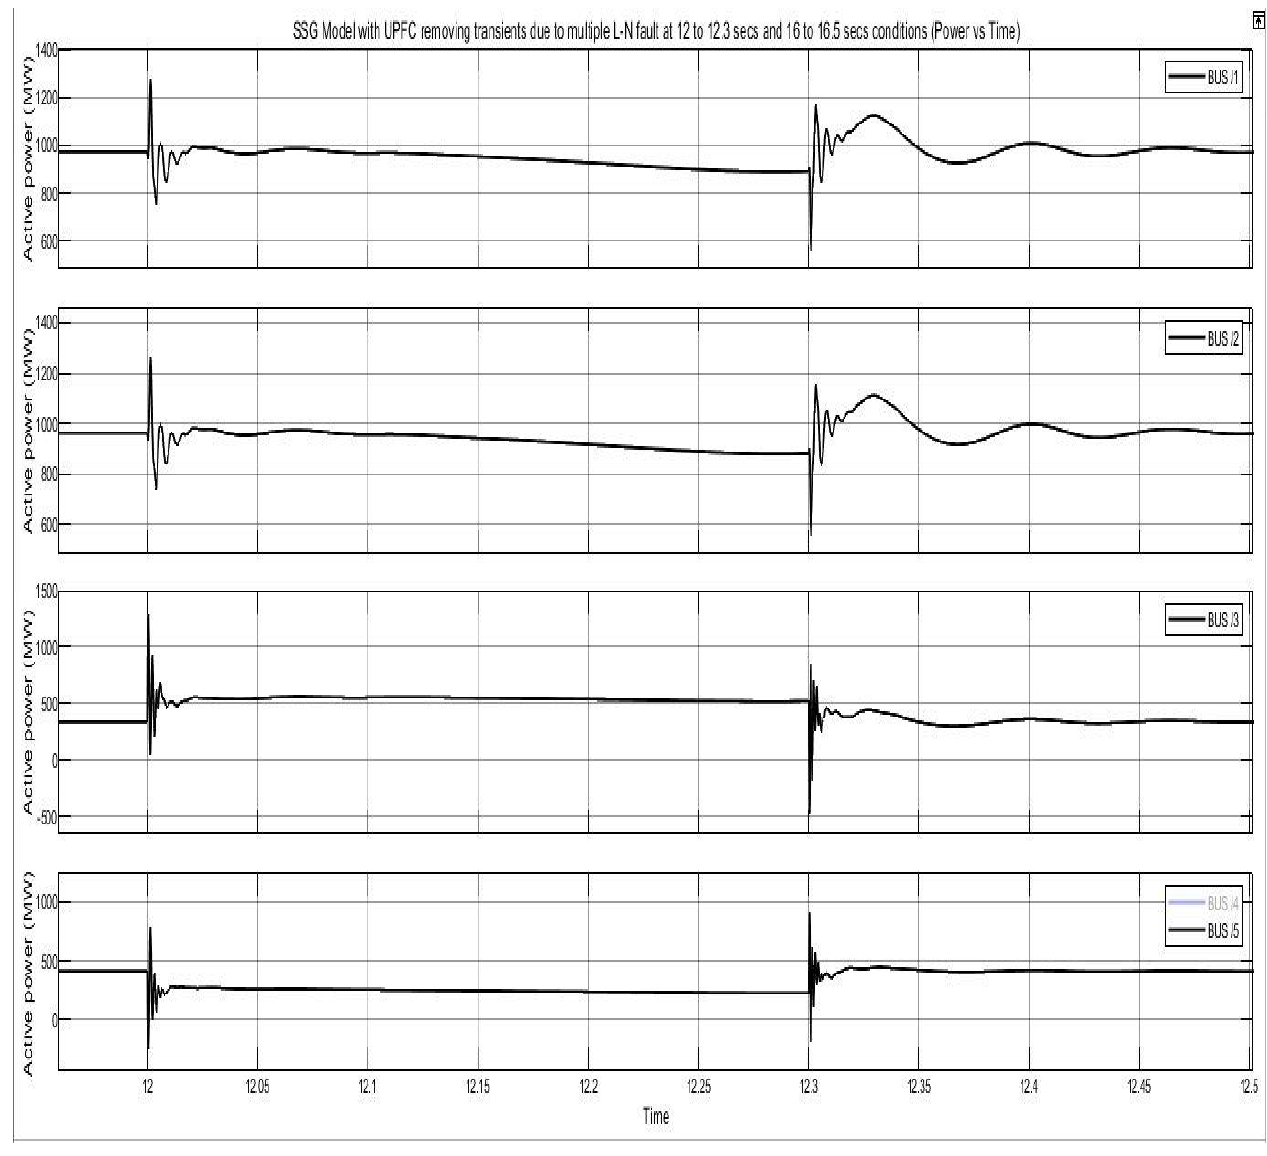
Figure 21. Transient stability being provided by UPFC at multiple L-G faults from 12 to 12.3 s (Bus 1 to Bus 5).